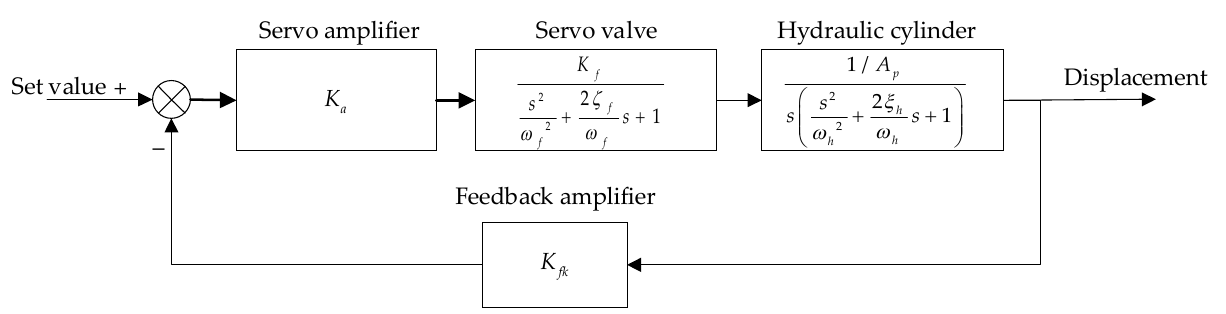
Figure 3. Control flow chart of valve-controlled hydraulic cylinder.